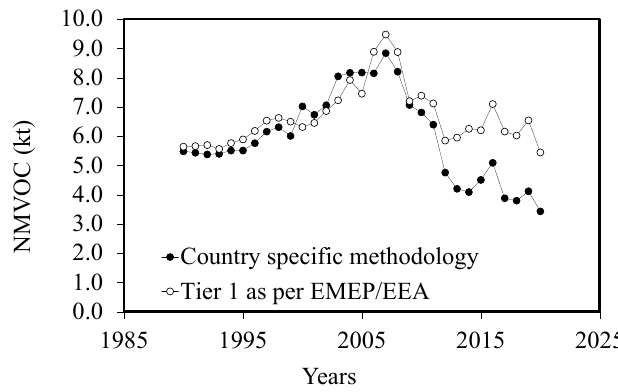
Figure 3. NMVOCs emissions from chemical products.